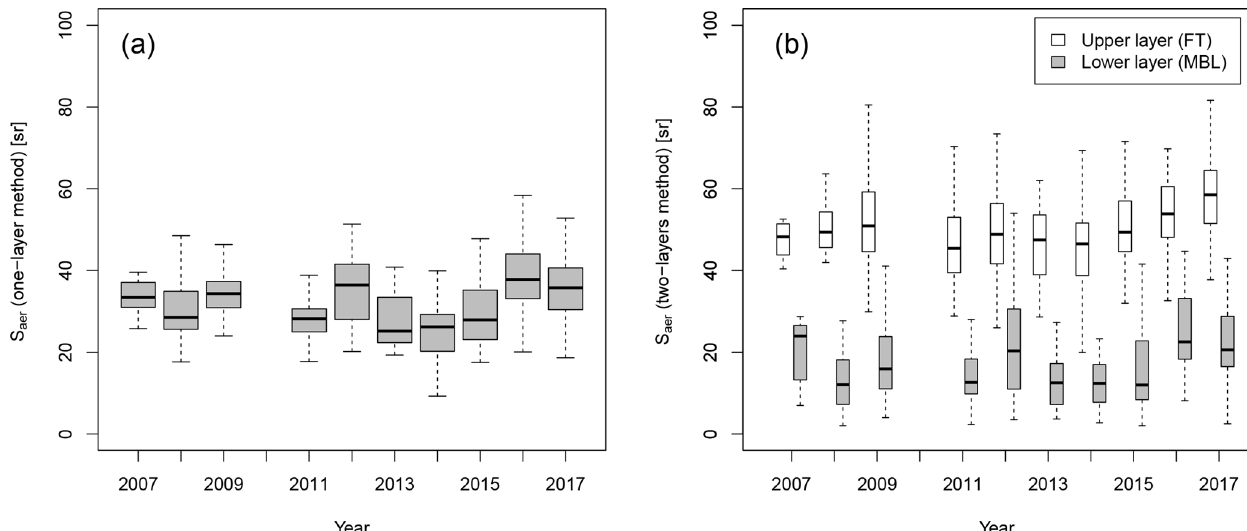
Figure 10. Lidar ratio at 523nm from (a) one-layer and (b) two-layer methods for each year between 2007 and 2017. The central rectangles extend from the first quartile to the third quartile and the median is represented by a horizontal line. The whiskers are defined as the upper and lower quartiles ± 1.5IQR (interquartile